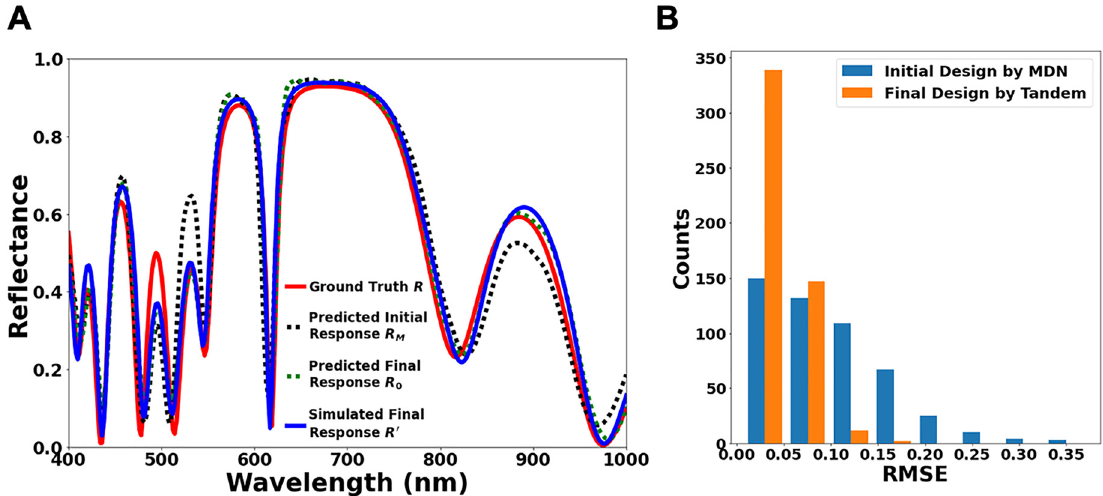
Figure2: (A) Comparisonof a requestedspectrum R (red curve)with thesimulatedresponse R ′ of the fi naldesignretrievedbythe model(blue curve) fora randomcase from thetest dataset.Forward modelpredictionsof the responseof theinitial MDNdesign R M (blackdash curve)and ofthe fi naldesign R 0 (greendashcurve)arealsoshown.(B)HistogramofRMSEmatchingbetweentherequestedspectrumandtheresponseof the model-suggested design for 500 randomly chosen test dataset samples before optimization (initial design from the MDN) and after optimization ( fi nal design by the tandem optimization